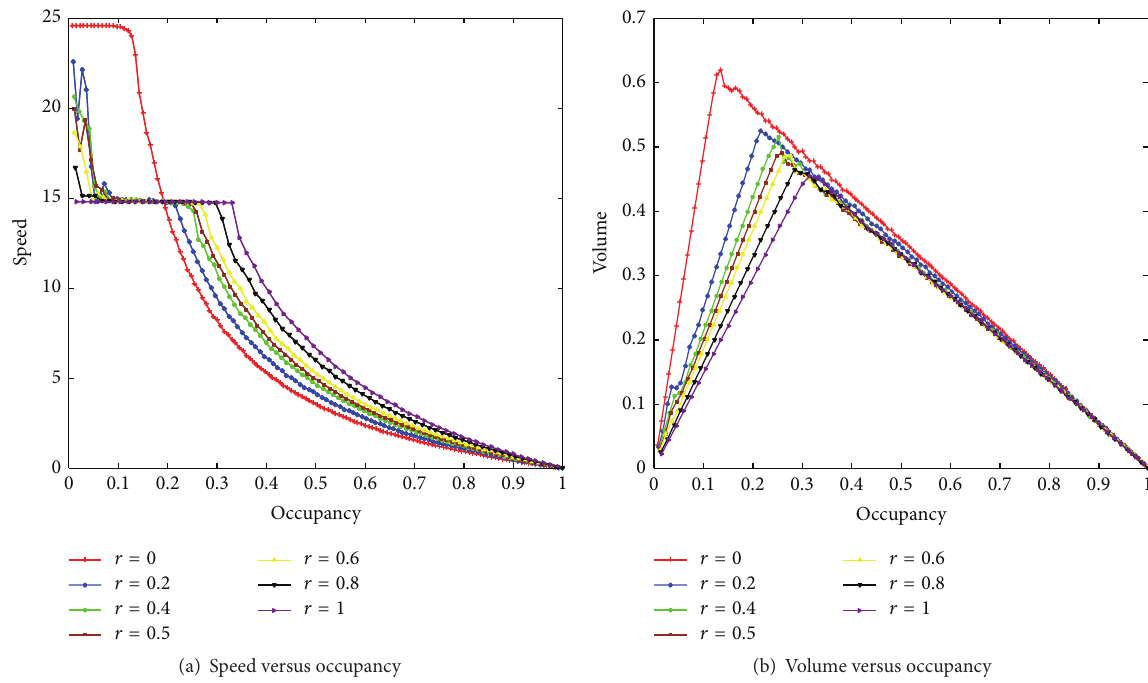
Figure 3: The fundamental diagram under different 𝑟 when imp =